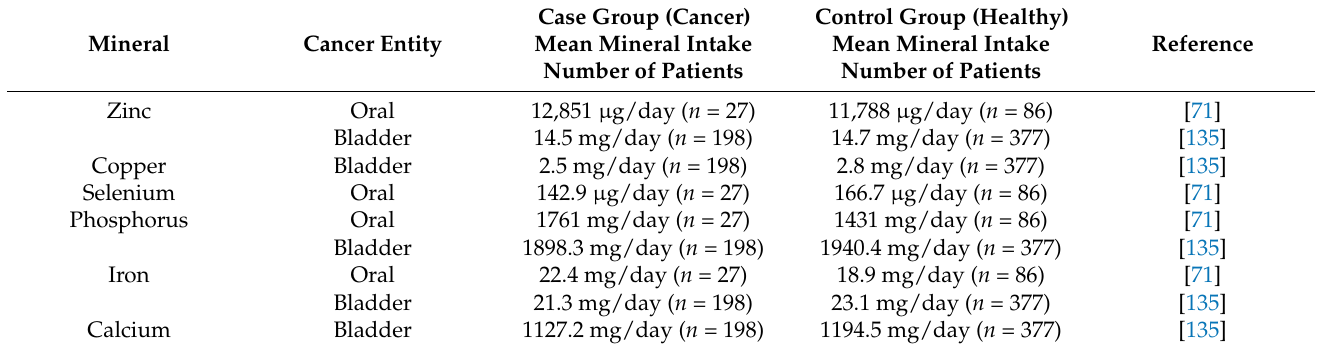
Table 4. Summary of the daily intake of minerals in the studies retrieved for the present